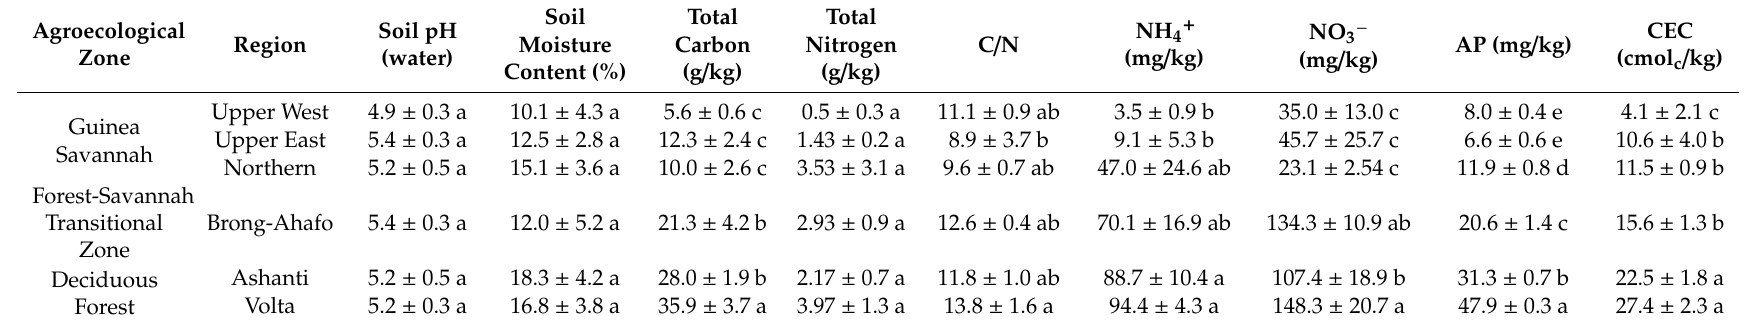
Table 1. Chemical properties of soil samples from six di ff erent regions under three agroecological zones in